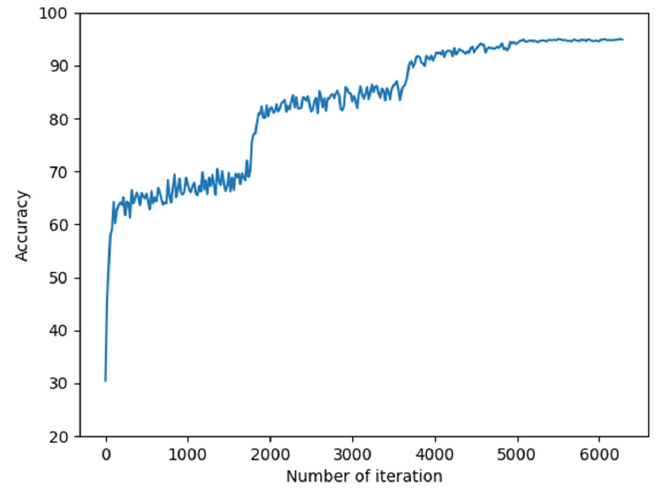
Figure 7. Accuracy of binarization model experiment.